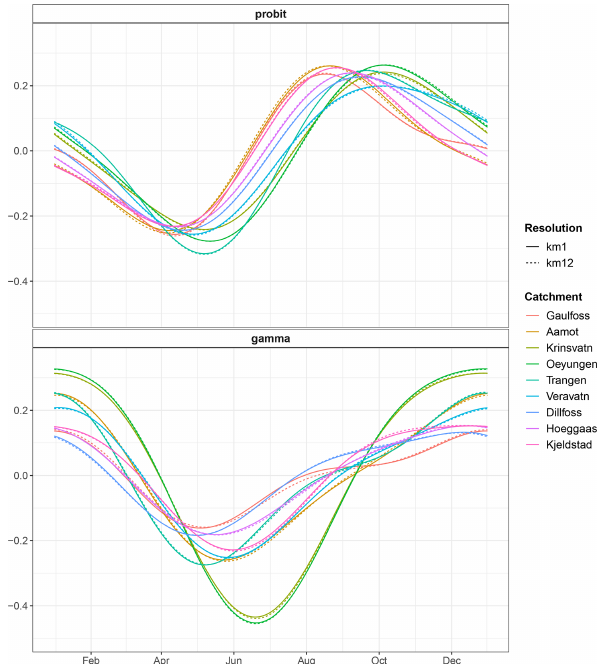
Figure 3. seNorge estimates of the seasonality component in Eq. (7) in the training period 1957–1986 for all catchments at both spa- tial scales. Top: the estimated seasonality in the mean of the latent Gaussian field µ st estimated by probit regression. Bottom: the esti- mated seasonality in the mean of the gamma distribution log (kθ st ) estimated within a GLM/GAM